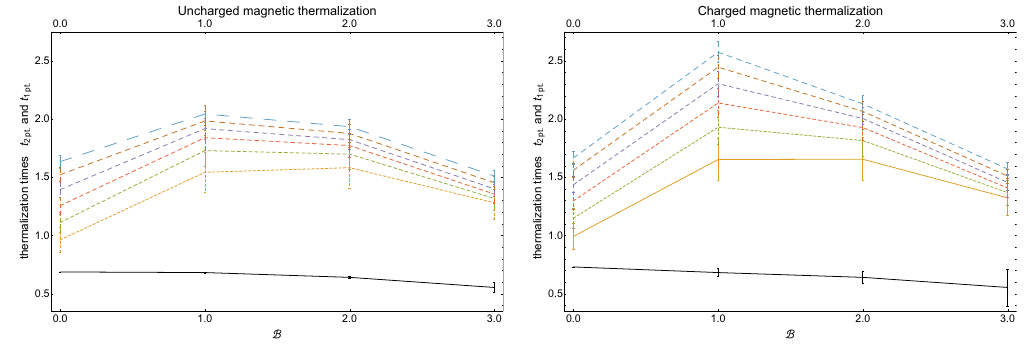
Table 10 . Thermalization times. The thermalization times of 1-point functions, t 1 pt: , 2-point functions, t 2 pt: , are determined according to the measure de(cid:12)ned in eq. (4.2). When nonzero, the charge density takes on the value (cid:26) = 0 : 78 (cid:26) e , that is 78% of the extremal charge density, (cid:26) e , of the Reissner-Nordstr(cid:127)om black brane.